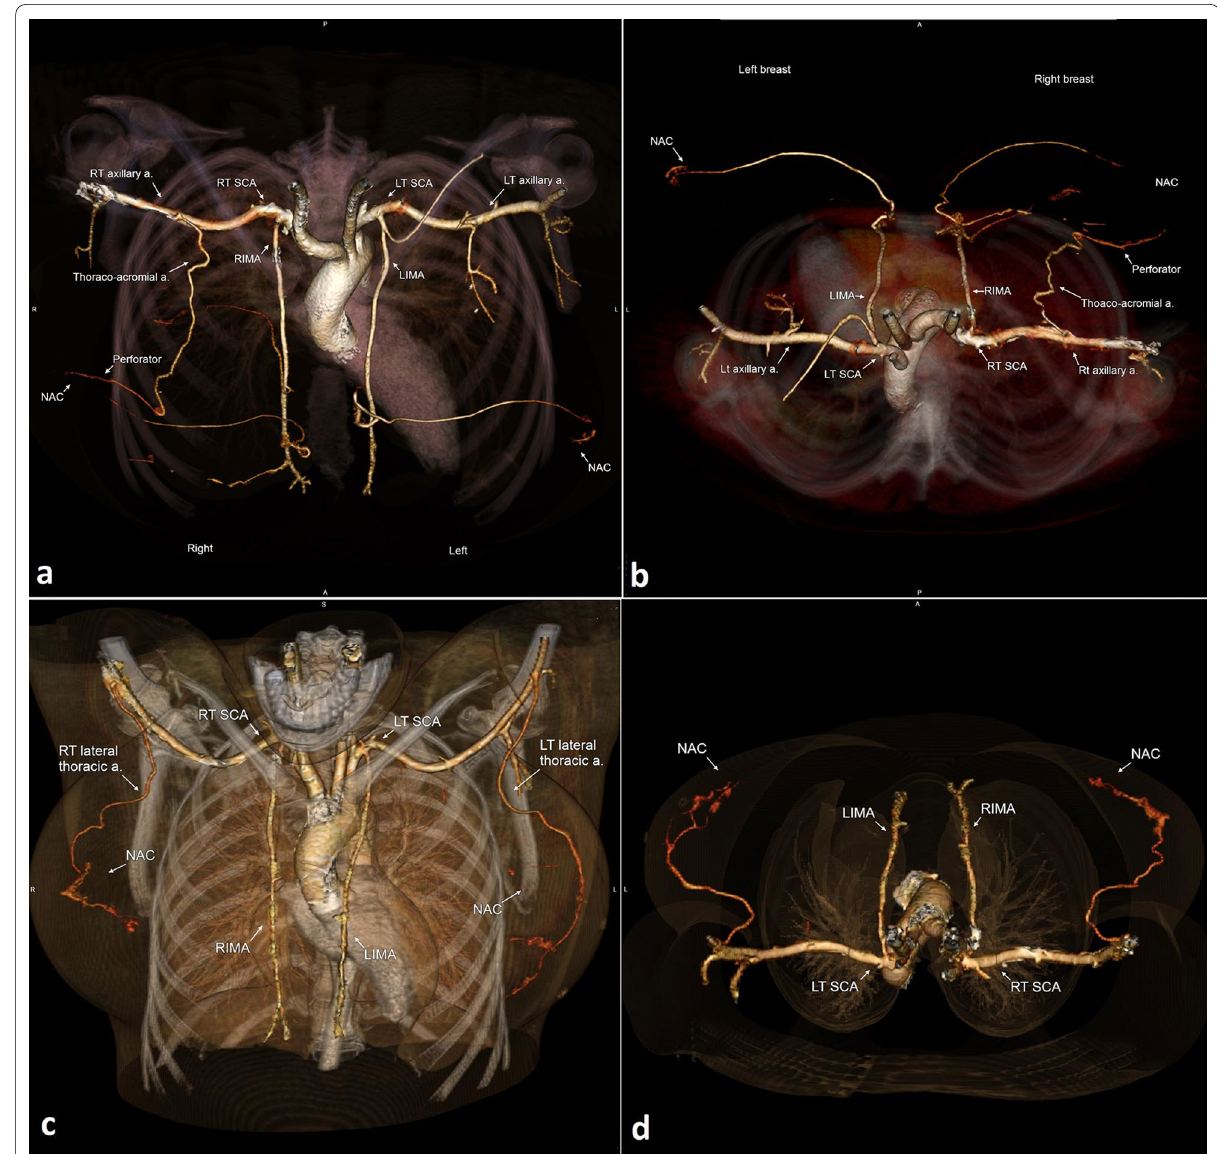
Fig. 5 Three-dimensional volume-rendered imaging of dominant arterial supply to NAC. Coronal ( a ) and axial ( b ) semitransparent 3D volume-rendered images of a patient with dominant supply from thoracoacromial artery and RIMA on the right breast reaching NAC. Another patient ( c & d ) shows dominant lateral thoracic artery supply on both sides. Note the relation of dominant arteries to bony structures and determination of entry site at NAC